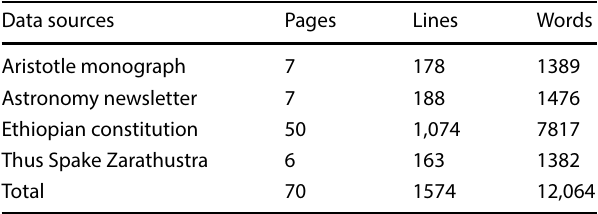
Table 2 Detail description of HARD-I dataset